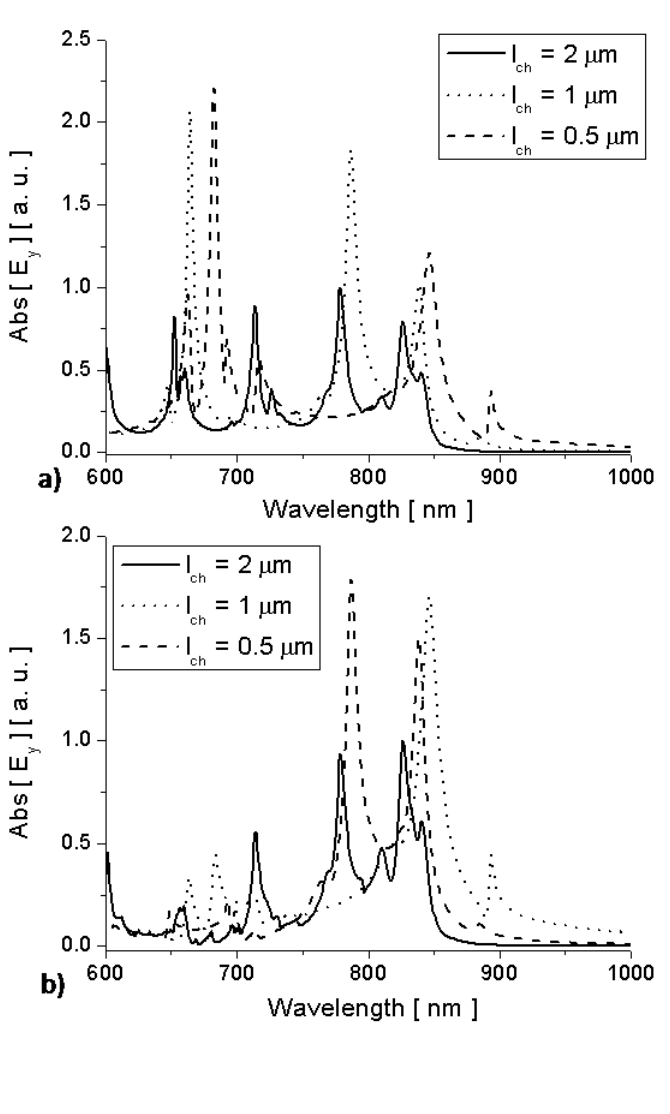
Figure 7. Simulation results for electric field amplitude (a) right inside and (b) right outside the channels of Figure